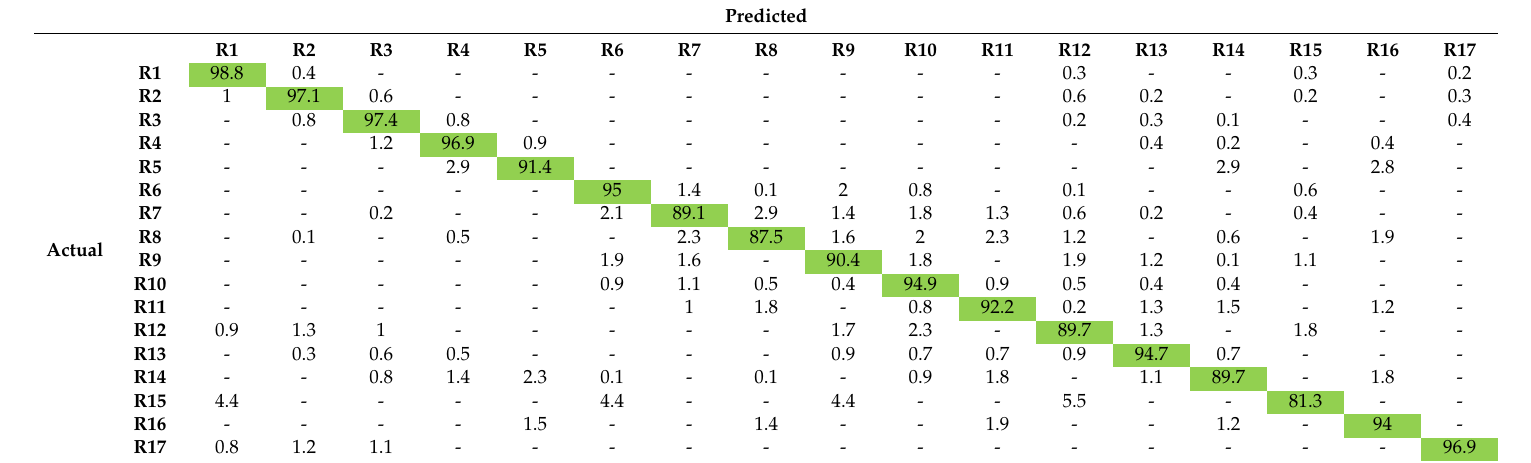
Table 5. Average confusion matrix of scheme 1 from two-fold cross validation.